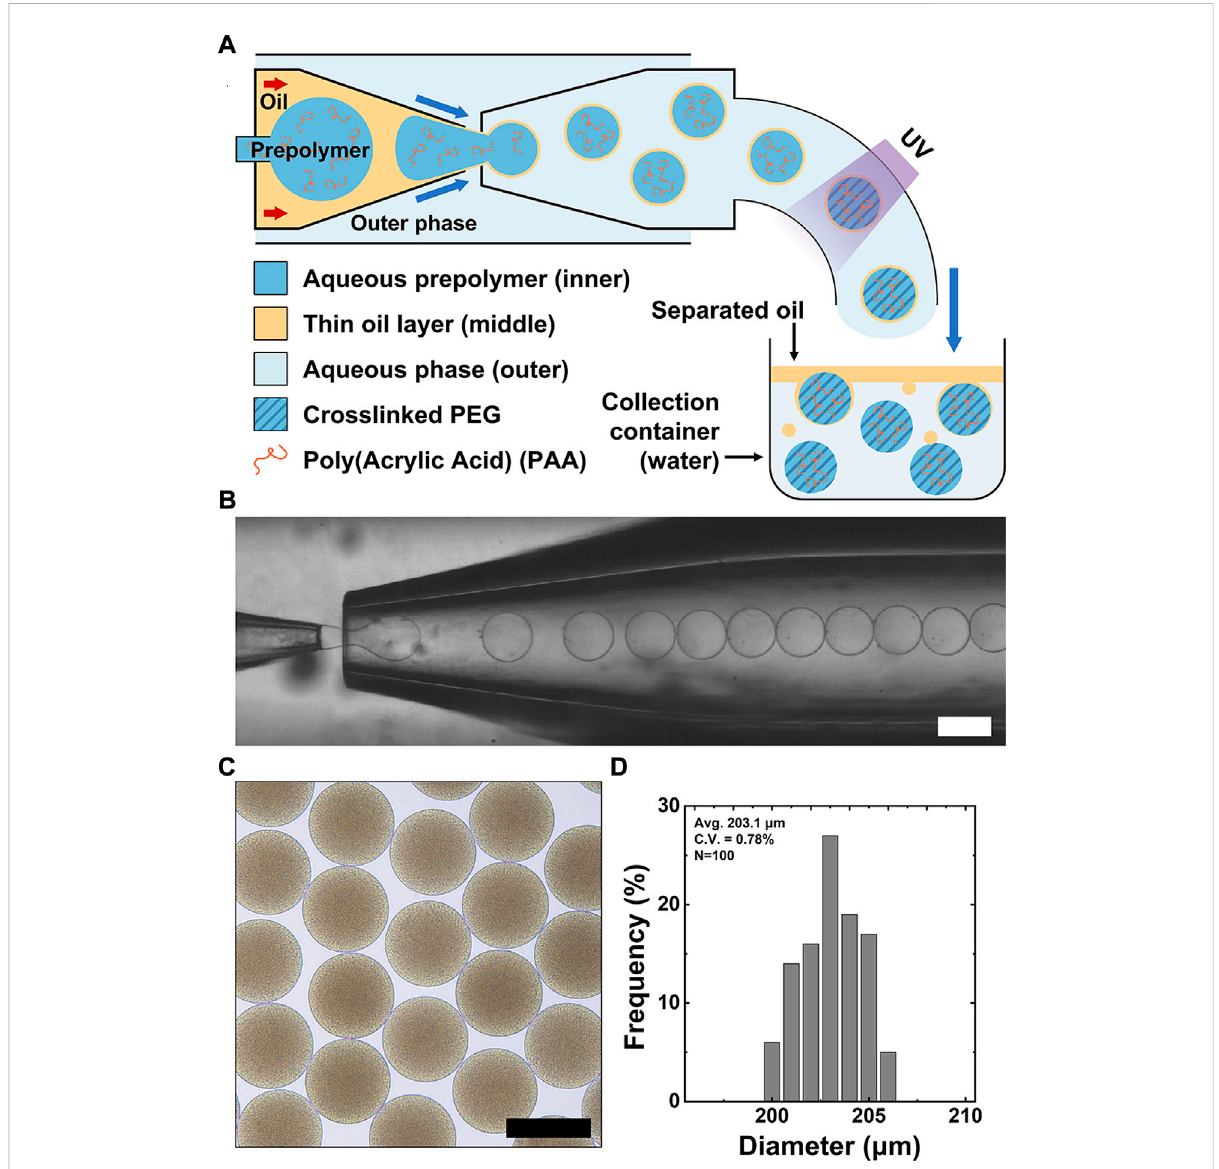
FIGURE 1 Capillary-based micro fl uidic production of PAA-functionalized PEG (PAA-PEG) microgels using double emulsion drops with a thin oil layer. (A) Schematic diagram of the glass capillary micro fl uidic device used to generate double emulsion drops containing polyethylene glycol diacrylate (PEGDA), PAA, and photoinitiator in the inner drop. These double emulsion drops are polymerized by UV illumination and collected in an aqueous solution to induce the thin oil layer ’ s dewetting from the polymerized microgels. (B) Bright- fi eld micrograph showing continuous stream of double emulsion drops. (C) Bright- fi eld micrograph showing uniform microgels dispersed in water. (D) Size distribution of the resulting microgels C.V. = 0.78%. Scale bars represent 200 μ